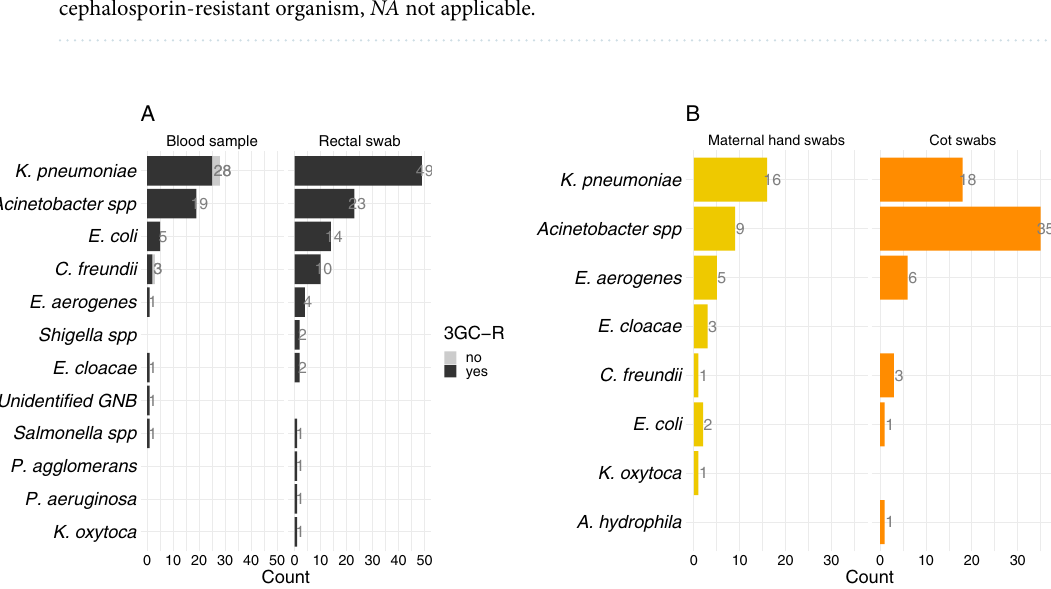
Figure 1. Gram-negative bacteria isolated from blood, and rectal, maternal hand and cot swabs, ( A ) Gram- negative organisms isolated from blood samples and rectal swabs. Dark grey shows 3GC-RO, light grey 3GC-susceptible. ( B ) Gram-negative organisms isolated from cot (orange) and maternal hand swabs (yellow), all